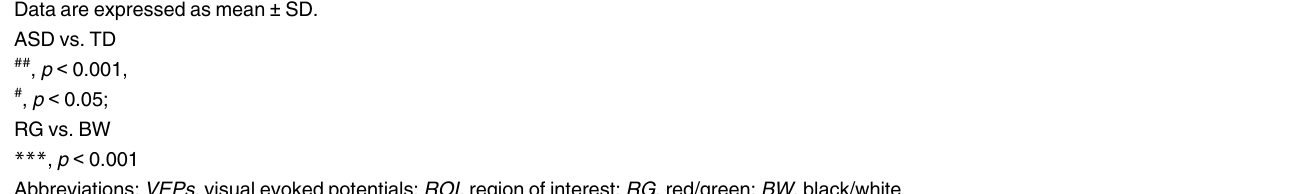
(C) N170 for face stimuli (right occipitotemporal ROI)